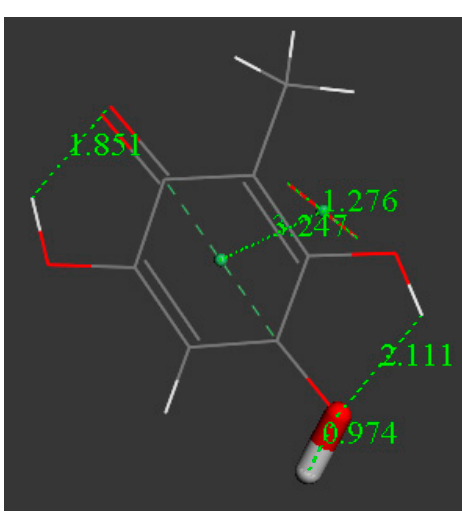
Figure 7. After superoxide donates the electron to the embelin-model ring, H 3 O + is reacted at one O(carbonyl), and the proton is captured. The formed species, [embelin-model-H] • , is a radical of neutral charge and this reaction has a Δ G of − 31.4 kcal/mol and no energy barrier,.